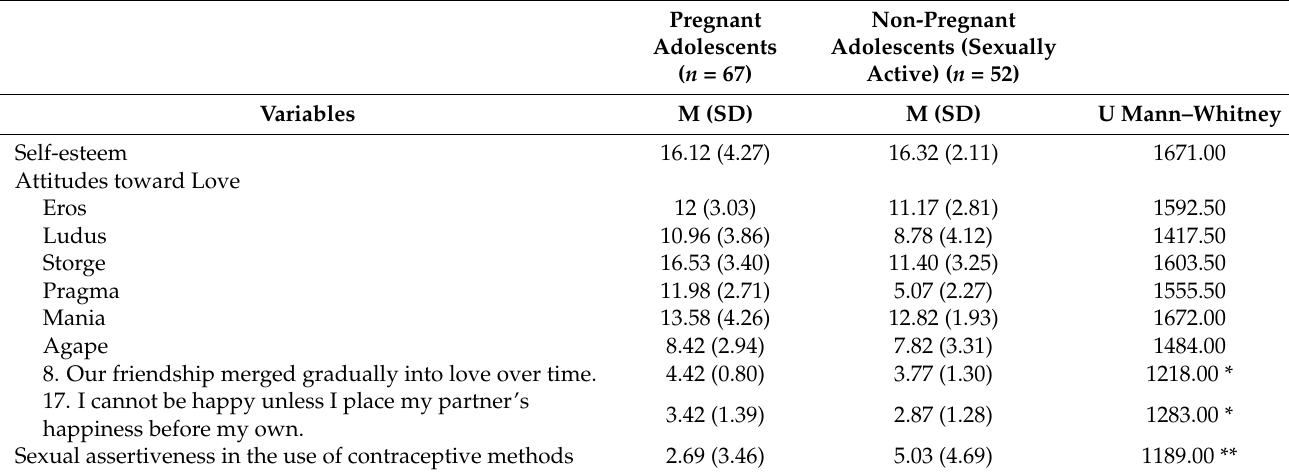
Table 3. Descriptive statistics and comparison in self-esteem, attitudes toward love, and sexual assertiveness between pregnant and non-pregnant women (sexually